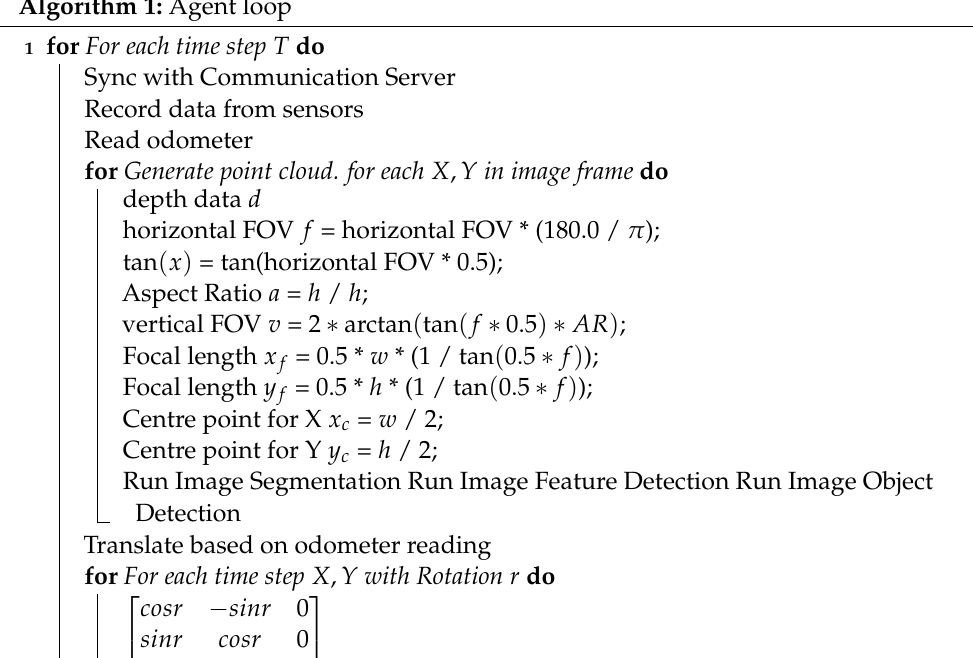
Algorithm 1: Agent loop